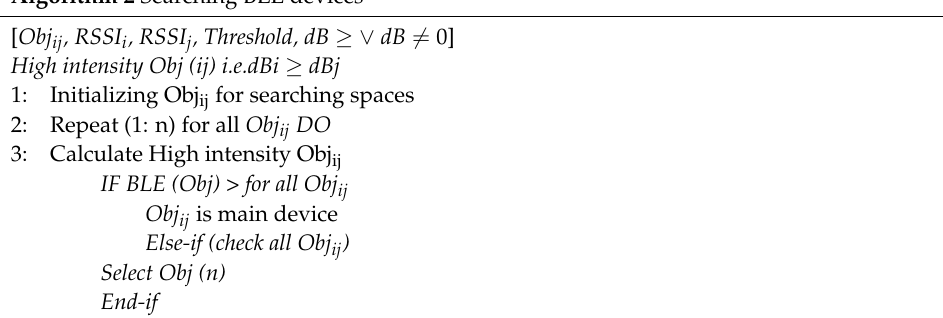
Algorithm 2 Searching BLE devices